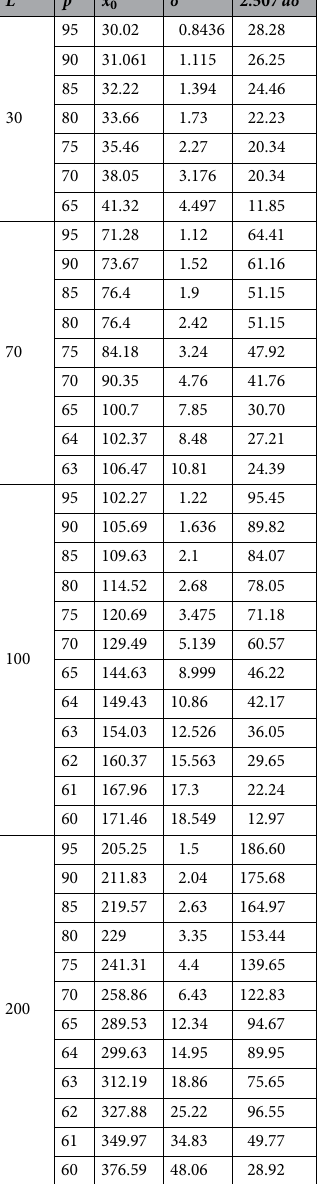
Table 1. Gaussian parameters ( x 0 , σ , A and AT = 2.507 A σ ) of the average output of active (AP) cells as functions of p for L = 30, 70, 100 and